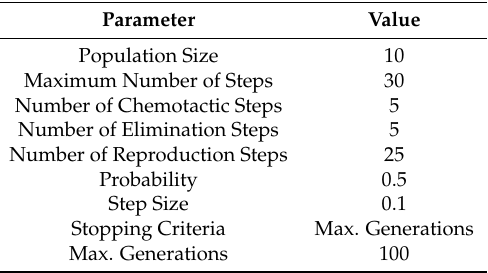
Table 13. BFAO parameters and values.